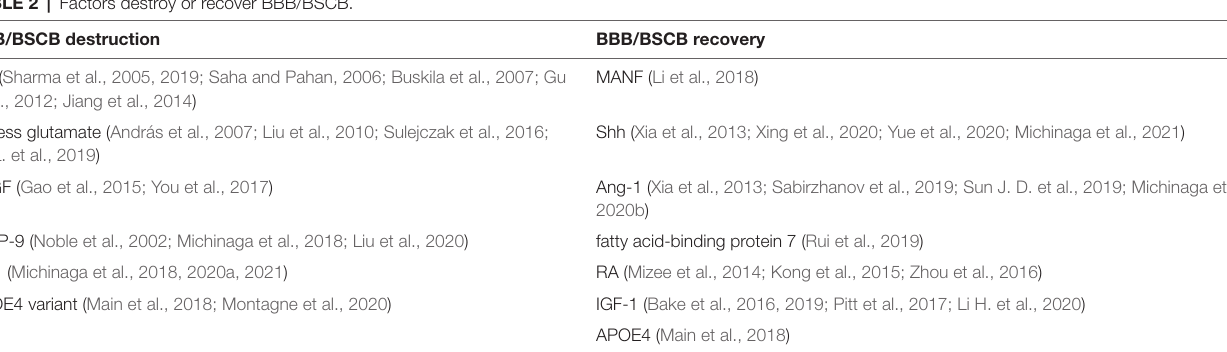
TABLE 2 | Factors destroy or recover